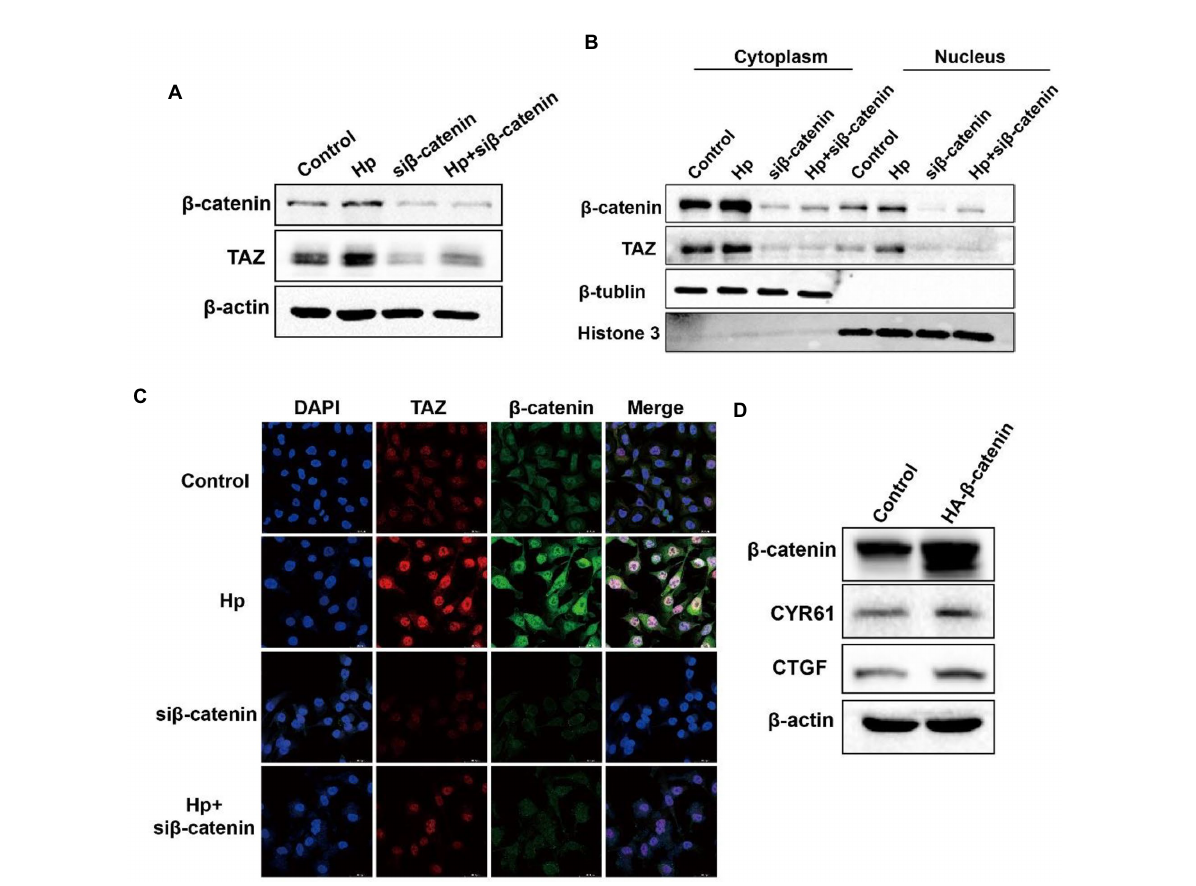
β -Catenin also acted as the upstream factor for TAZ activation and exhibited enhanced interaction with TAZ in response to H. pylori infection. (A) After knocking down β -catenin by siRNA, AGS cells were cocultured with the H. pylori strain. Western blot analysis of TAZ total expression. (B) Western blot analysis of TAZ and β -catenin expression in the cytoplasmic and nuclear fractions after treatment with β -catenin siRNA and the H. pylori strain. β -Tubulin and histone H3 served as loading controls for cytoplasmic and nuclear proteins, respectively. (C) Immunofluorescence staining for TAZ and β -catenin subcellular localization in the groups treated as described above. (D) Western blot analysis of the protein levels of CTGF and CYR61 in AGS cells expressing HA- β -catenin plasmid or empty vector. H. pylori strains in all experiments were used at an MOI of